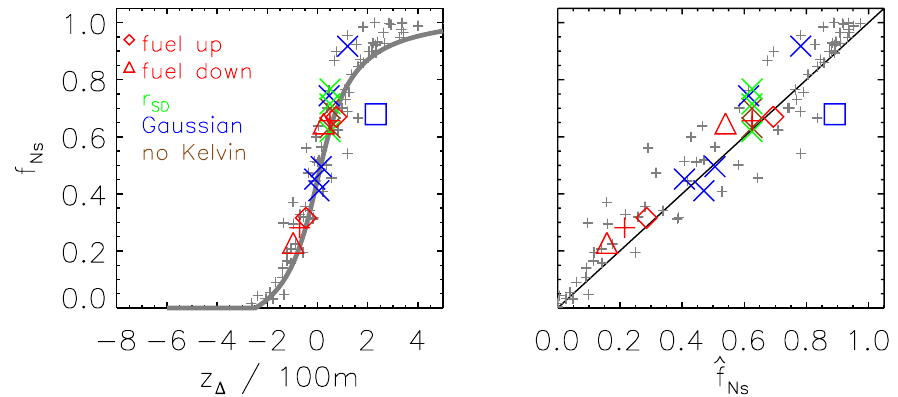
Figure 12. Plots as in Fig. 5. Grey symbols show all simulation data from Fig. 5. The coloured symbols show sensitivity simulations (see legend) not yet